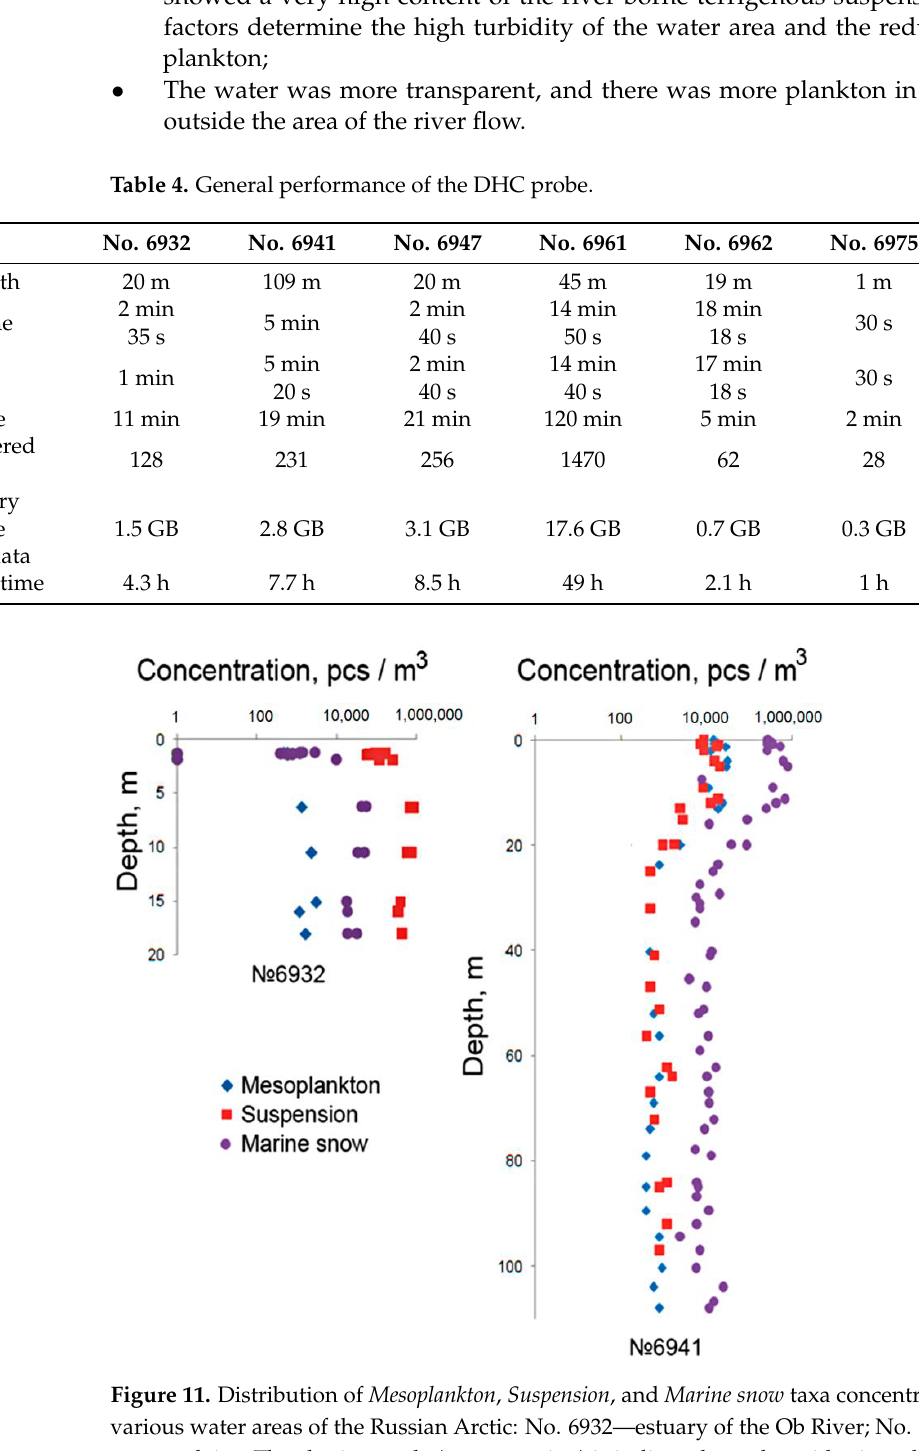
Table 5. Data for comparison of plankton measurements at station No. 6995.